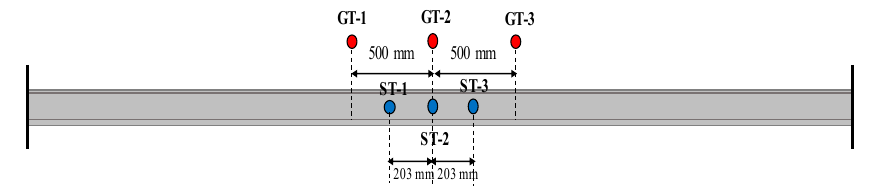
Figure 12. Monitoring point locations for the gas cloud temperature and steel temperature.